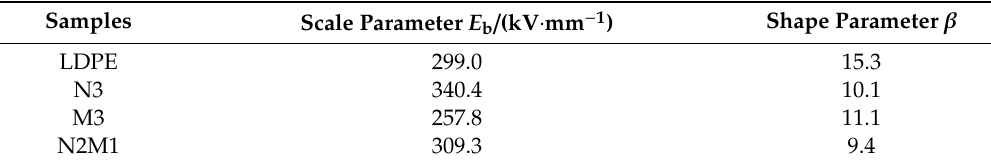
Figure 8. DC Breakdown strength data with 2-parameter fitted Weibull distribution for neat LDPE and ZnO/LDPE composites. Table 2. The characteristic 63.2% DC breakdown strength and Weibull distribution fitting parameters in a 95% confidence interval. The scale and shape parameters are denoted as E b and β , respectively.